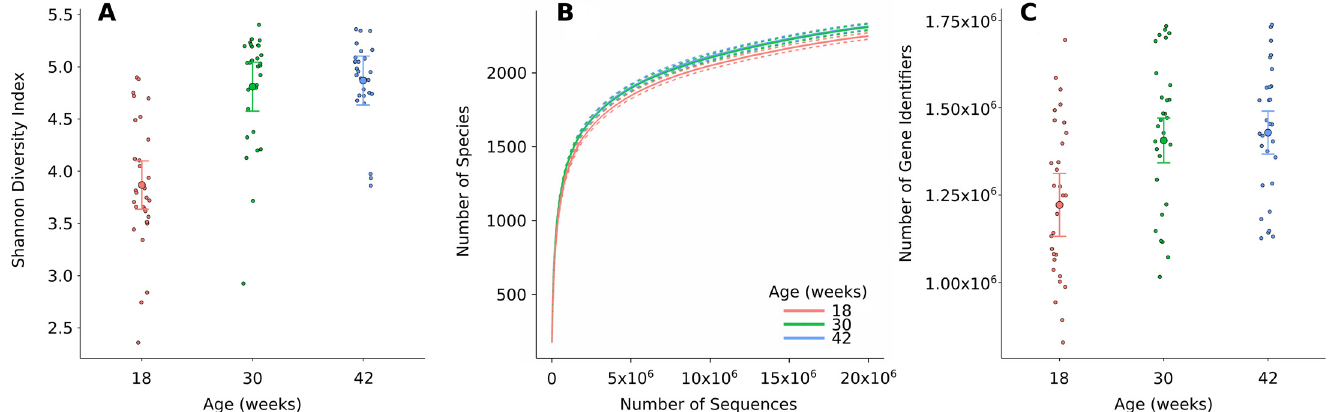
Fig 1. Species diversity and richness at 18, 30 and 42 weeks of age. (a) Shannon diversity indices as inferred from normalized species counts. (b) Rarefaction analysis of species richness. (c) Gene richness shown as the number of unique protein coding genes (unique GI numbers). Species diversity, species richness and gene richness increased with age but only differences from week 18 to weeks 30 and 42 were statistically significant. No significant associations with neuter date or gender were found (S3 and S4 Tables).